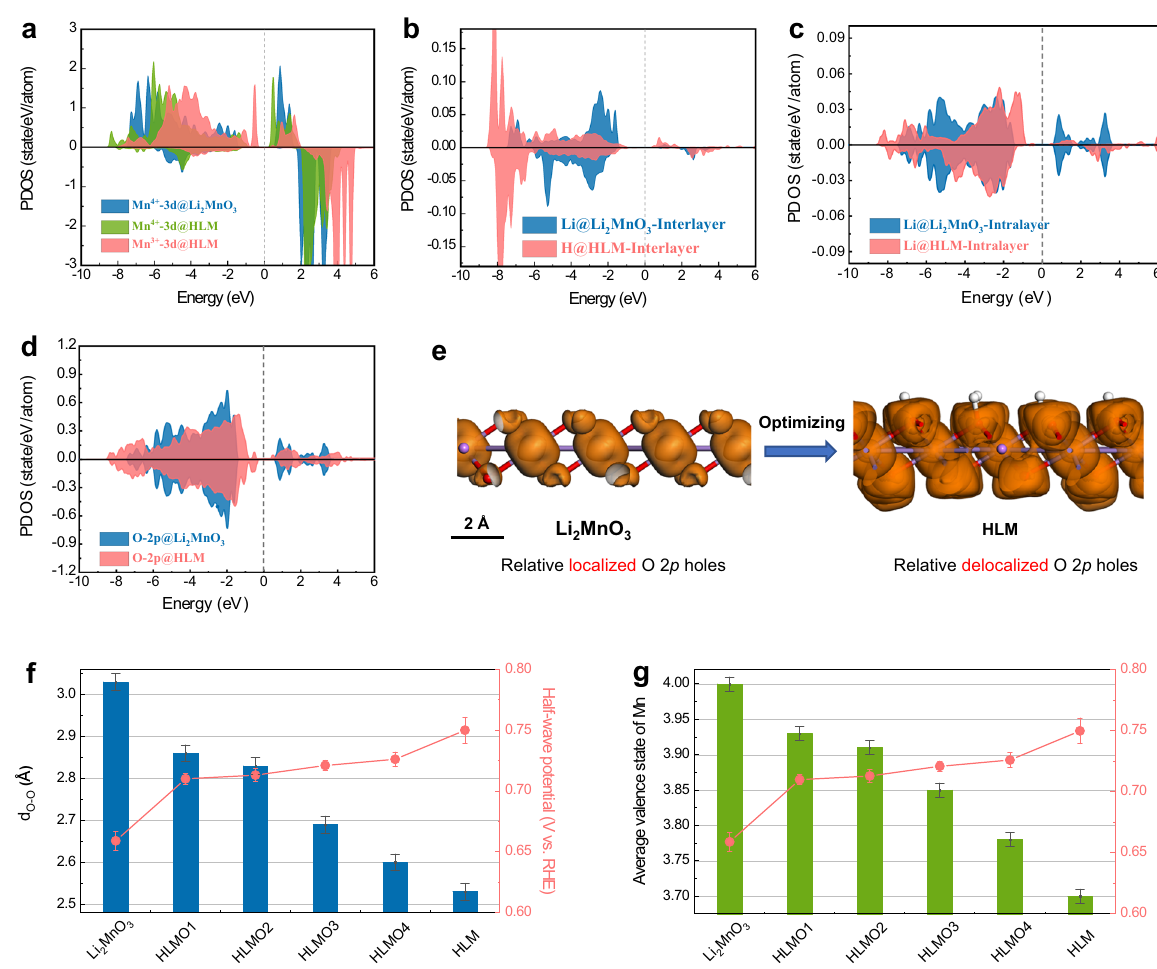
Fig. 5 Theoretical description and mechanistic study. Comparison of the PDOS of Li 2 MnO 3 and HLM systems with a Mn- d orbitals, b interlayer Li- s (in Li 2 MnO 3 ) and H- s (in HLM), c intralayer Li- s , and d O- 2p orbitals. The energy is shifted relative to the Fermi level of HLM. e Band decomposed charge density of the lowest conduction band (between 0 and 2 eV above the Fermi level) before and after proton exchange. Relationships of f interlayer distances and g Mn valence states versus ORR activity with respect to half-wave potentials. Error bars represent the standard deviation of at least three independent